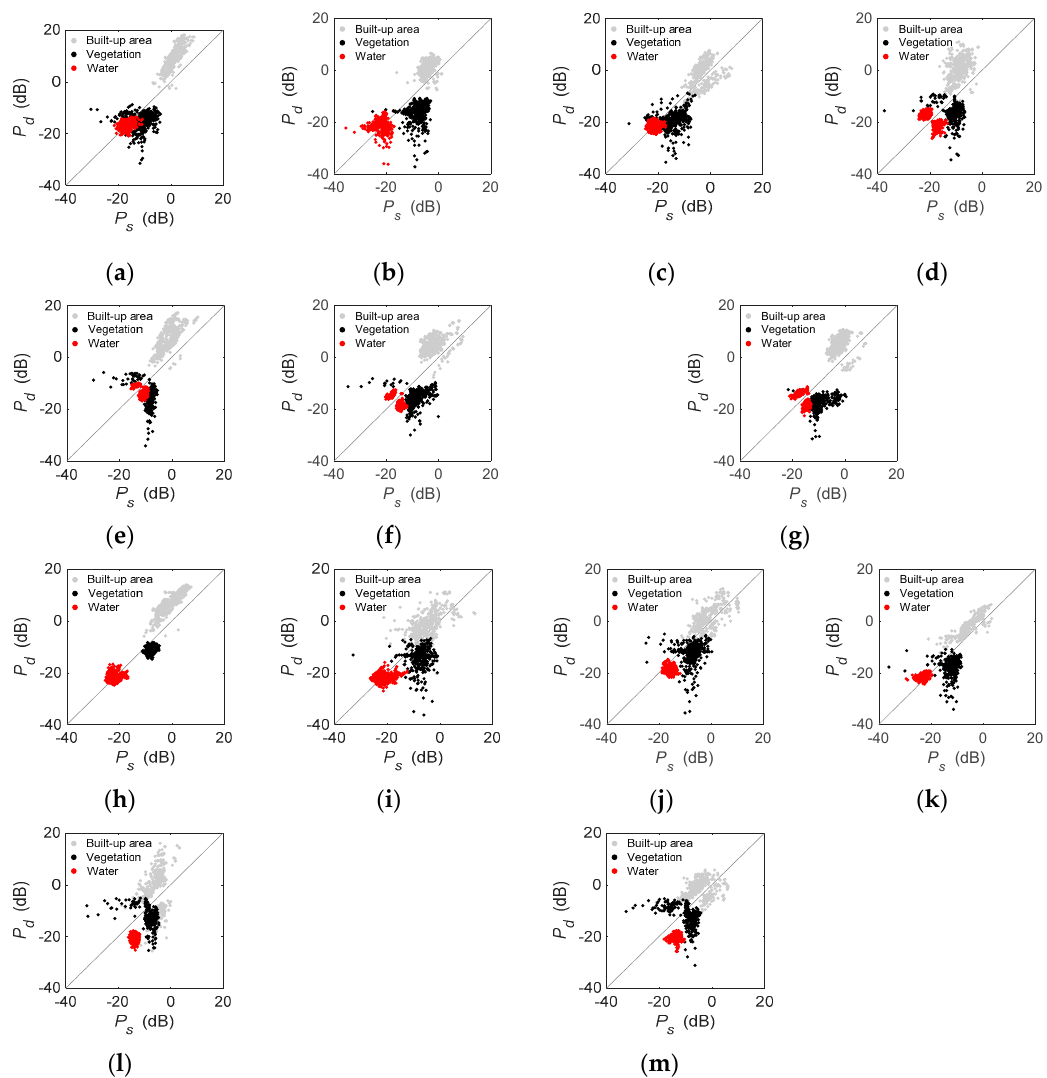
Figure 8. Scatter diagrams of built-up areas, vegetation, and water in double-bounce and surface-scattering powers. ( a ) GF-1703, ( b ) GF-1710, ( c ) GF-1712, ( d ) R2-0903, ( e ) A2-1603, ( f ) A2-1610, ( g ) A2-1612, ( h ) GF-1702, ( i ) GF-1705, ( j ) GF-1708, ( k ) R2-1607, ( l ) A2-1504, and ( m ) A2-1601.